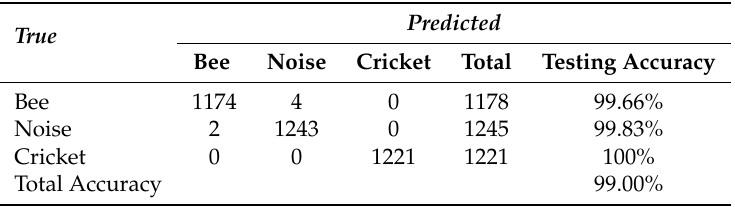
Table 6. Confusion matrix for M1 (Logistic Regression) with train/test and no scaling (S1) on BUZZ1 train/test dataset with 60-40 train/test split.